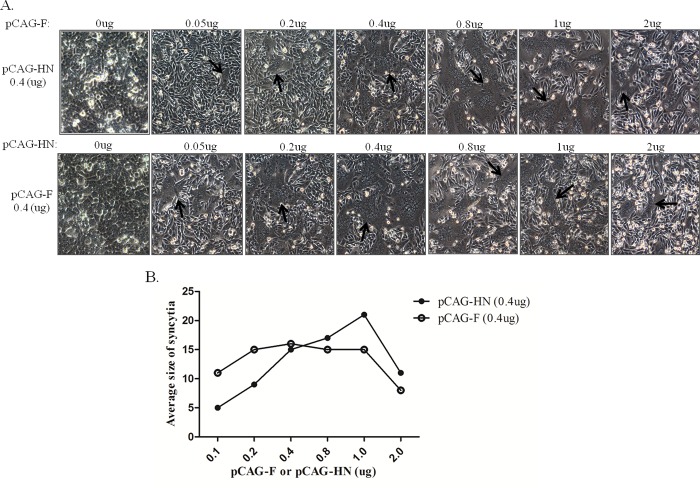
Dose-dependent induction of syncytia formation by F and HN proteins in BHK-21 cells.Cells were co-transfected with different amounts of pCAG-F and pCAG-HN. Syncytia were counted based on nuclei. (A) Syncytia formation is indicated by black arrows. (B) Syncytia were quantitated using the average size method.